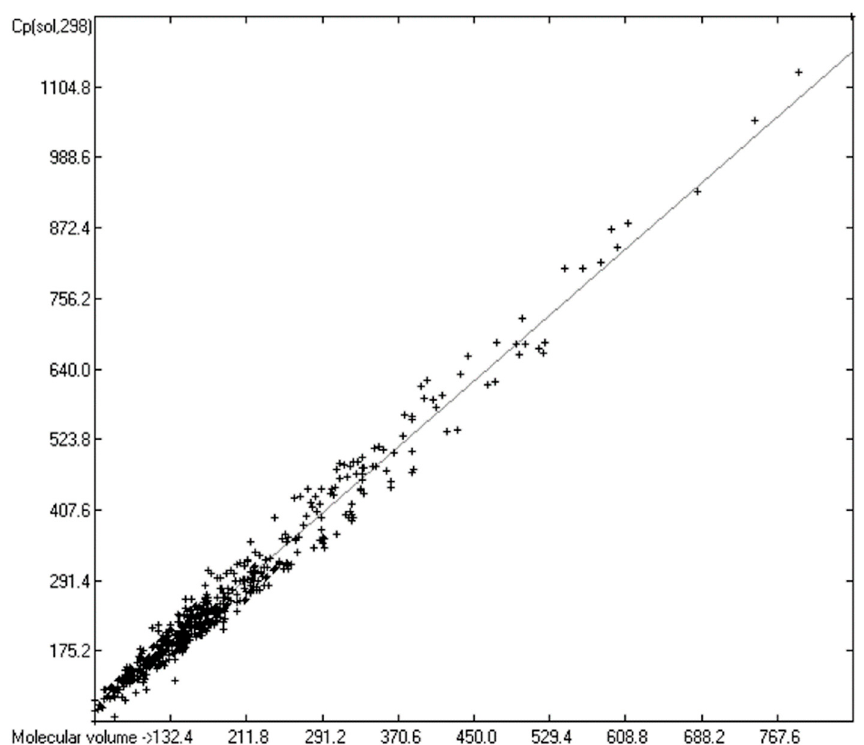
Figure 11. Correlation of molecular volumes with Cp(sol) at 298.15 K of OH-free compounds. (N = 555, R 2 = 0.9766, σ = 23.14 J/mol/K, MAPD = 7.19%, regression line: intercept = 2.8899, slope = 1.3669, value range from 59.4 to 1220.9 J/mol/K).